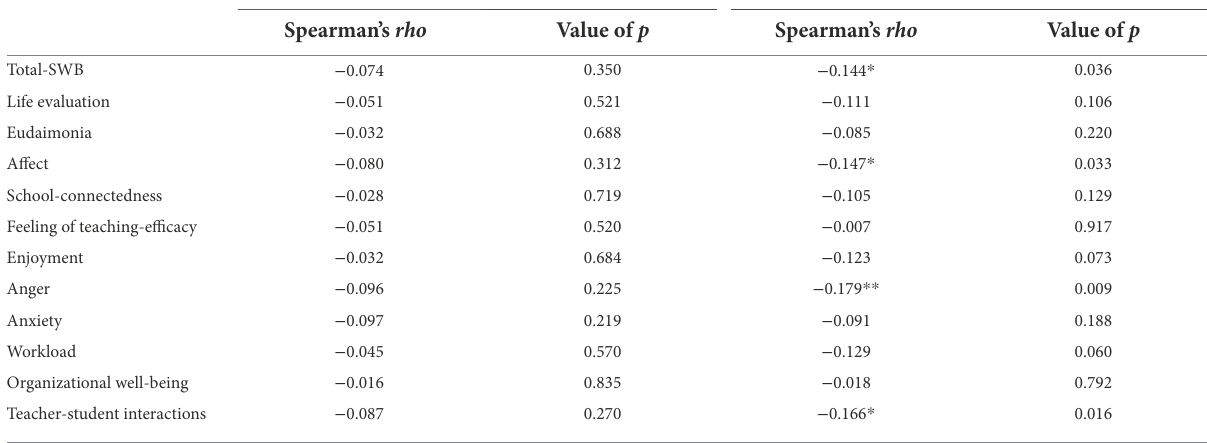
TABLE 3 SWB scores correlations with number of